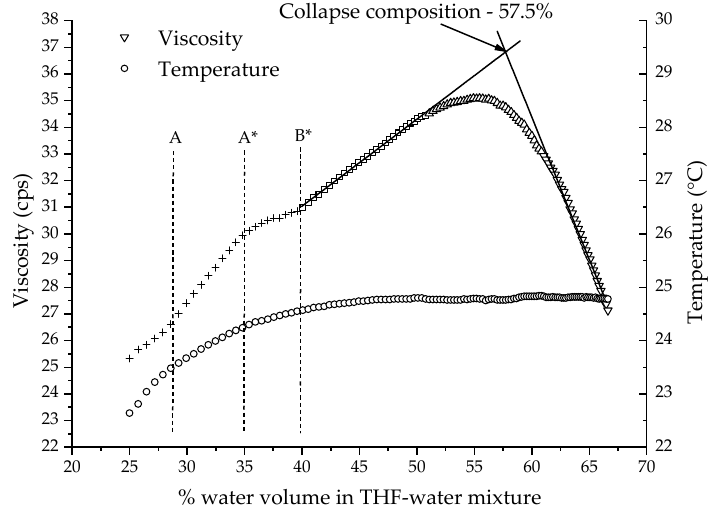
Figure 11. Water reduction (viscosity against % volume of water present in the THF/water solvent composition) plot for Polymer 2.